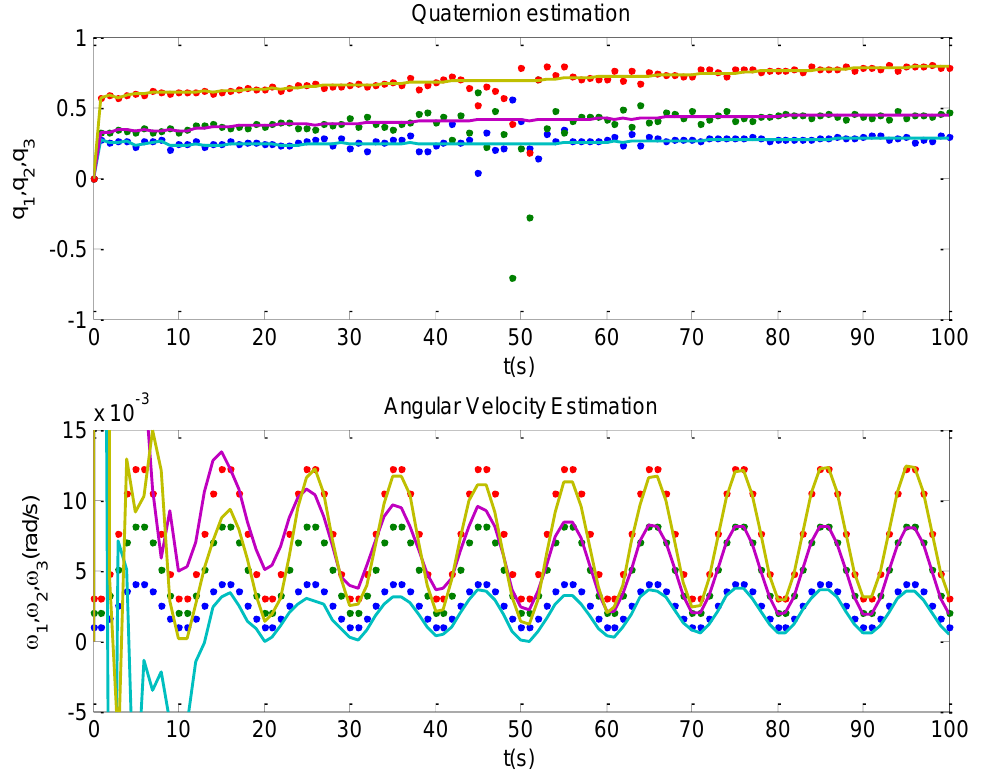
Figure 6. Result of the proposed calculation of quaternion variances, taking the same simulated example as in Figure 5. Top plot shows determined (dots) and estimated quaternion (solid). Bottom plot shows simulated (dots) and estimated (solid) angular velocity. In this case the filter isolates ill condition measurements and reduces accommodation.